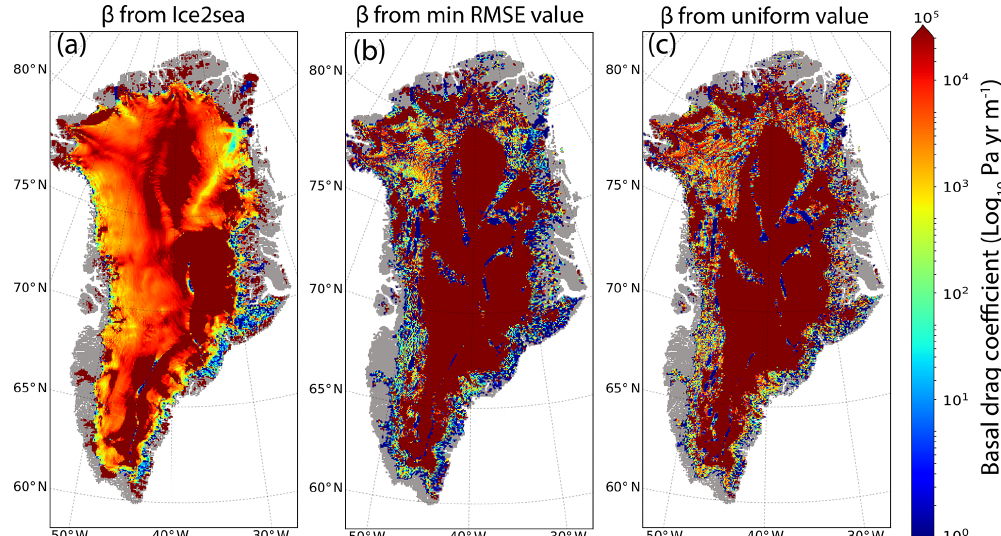
Figure 2. Spatial distribution of the basal drag coefficient (log 10 Payrm − 1 ) in (a) the initial condition, used in the GRISLI Ice2Sea simula- tions; (b) the iterative cycle that produces the minimal RMSE (Nb cycle = 9) when using Ef = 1 for Nb inv = 20 years and Nb free = 200 years (Sect. 4.2); (c) the iterative cycle that produces the minimal RMSE (Nb cycle = 9) when using Ef = 1 for Nb inv = 20 years and Nb free = 200 years but starting from a uniform basal drag coefficient (Sect.